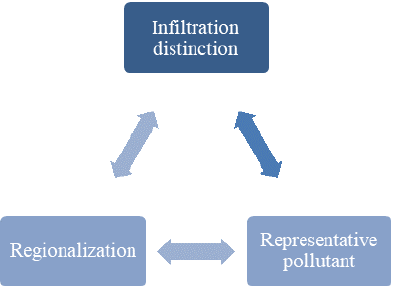
Figure 4. The proposed principles for an integrated evaluation of